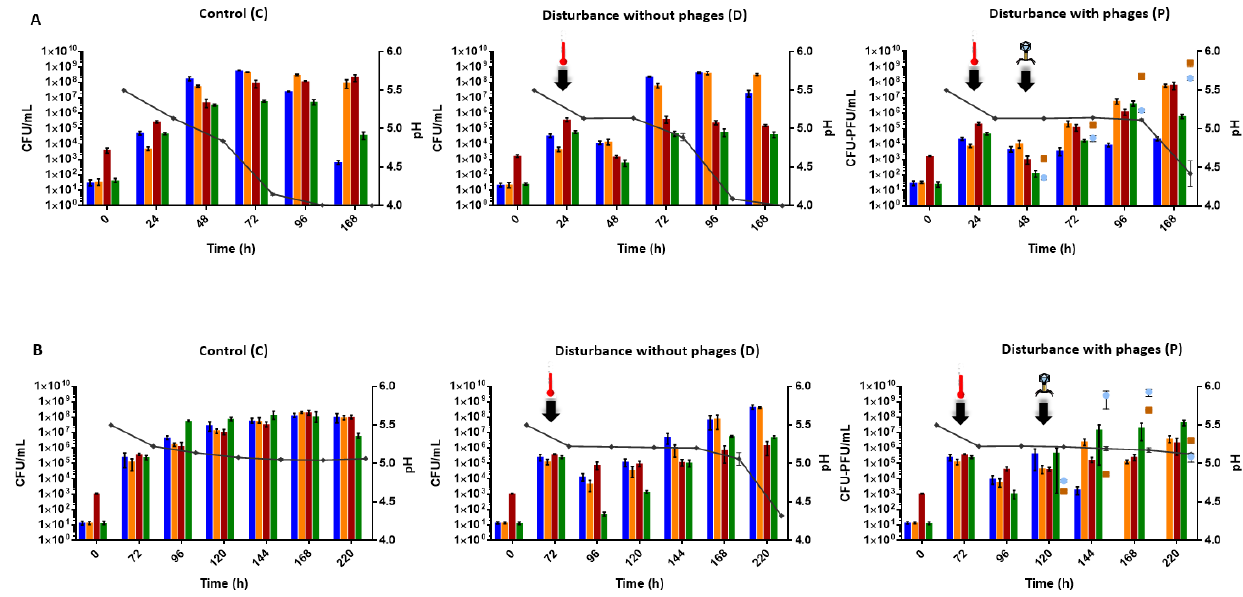
Figure 2. Dynamics of the microbial populations and pH (black curve) of the model microbial community in the three experimental conditions (control, disturbance without phages and disturbance with phages) at 25 °C ( A ) and at 15 °C ( B ). Ln. mesenteroides CIM 3004 is represented in blue, L. mali UCMA 16447 in orange, O. oeni UCMA 19297 in red and S. uvarum UCMA 10446 in green. Phage UCMA 21115 was added at a MOI of 0.1 and phage PLE001 at a MOI of 0.01, and are represented with orange squares and blue circles, respectively. The black arrows indicate heat shock and phage addition. The values were derived from biological triplicates and error bars represent standard